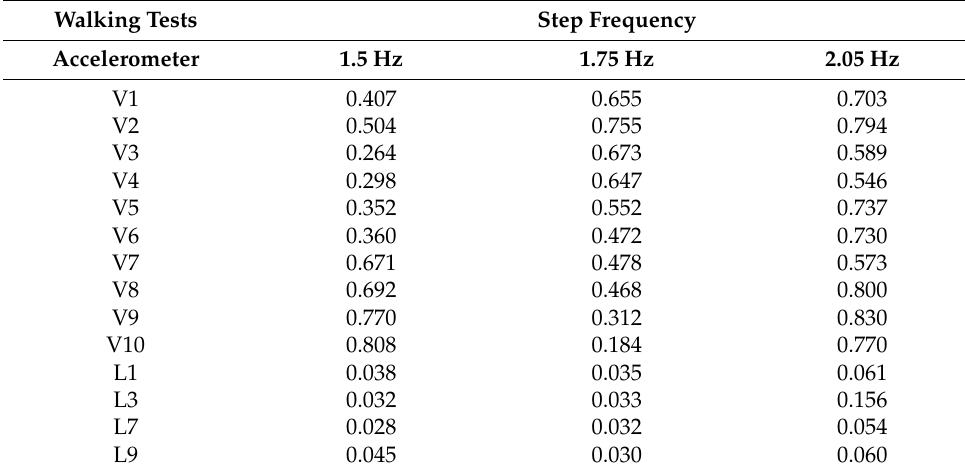
Table 4. Maximum acceleration responses due to different walking load tests [m/s 2 ].